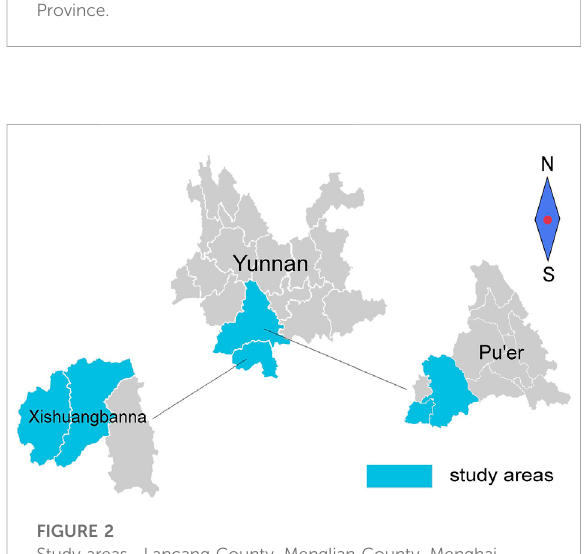
FIGURE 1 Study areas — Qichun County and Shashi District in Hubei Province.